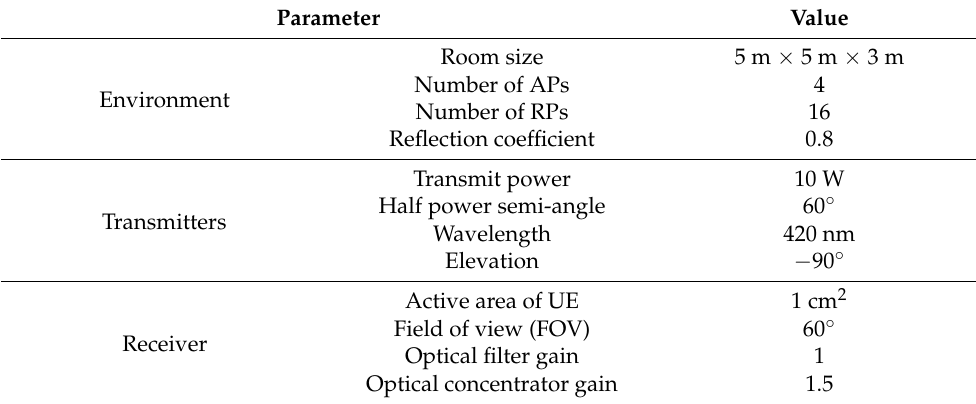
Table 5. Simulation